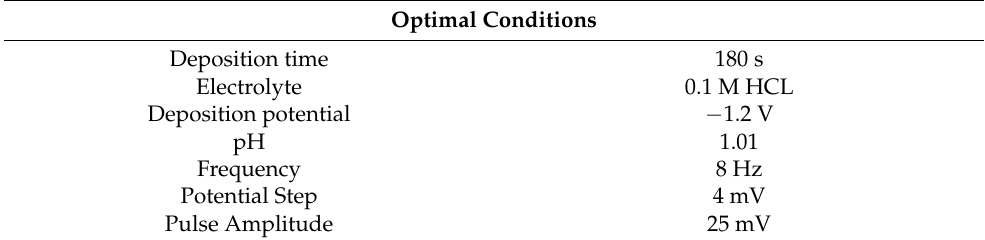
Table 4. Optimal conditions for the electrochemical deposition of Pb 2+ analyte.